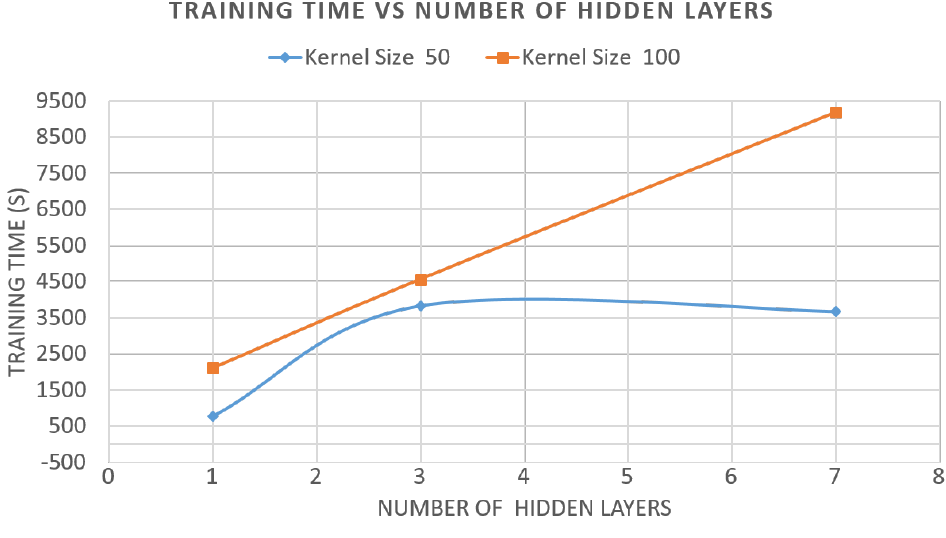
Figure 9. Comparison between the total training time and the number of hidden layers for the FNN when fixing the kernel size to 50 (blue) and 100